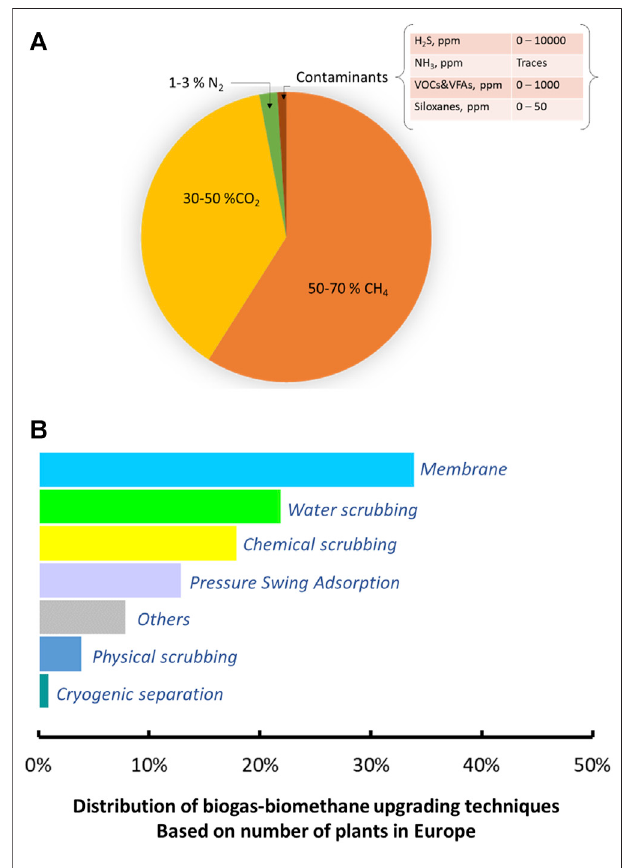
FIGURE 1 | (A) Typical raw biogas composition on a dry basis; (B) biogas-biomethane upgrading techniques based on the number of plants in Europe in 2019. Adapted from European Biogas